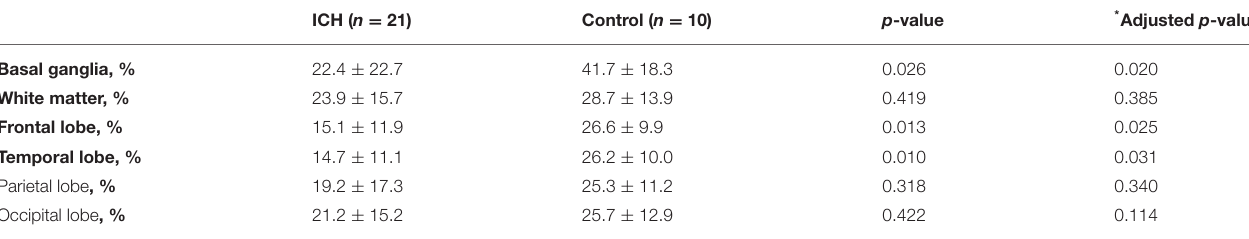
TABLE 2 | Comparison of ASL perfusion reduction in spontaneous intracerebral hemorrhage and controls. ICH ( n =